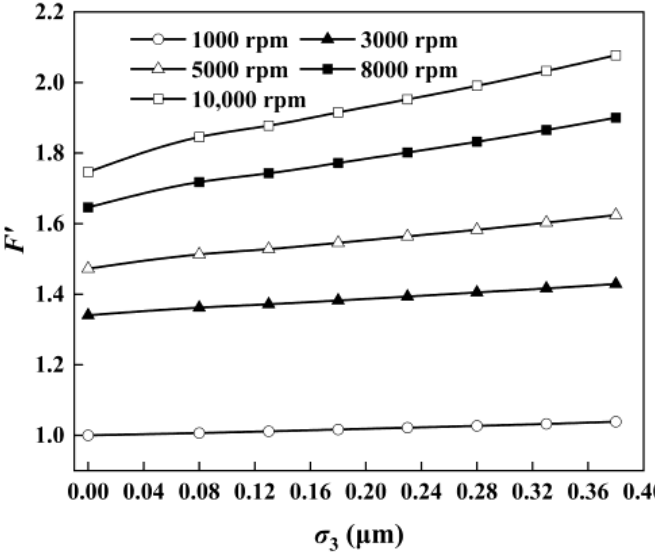
Figure 14. Effect of the roughness of the stationary ring surface on the opening force of the lubrica- tion film.